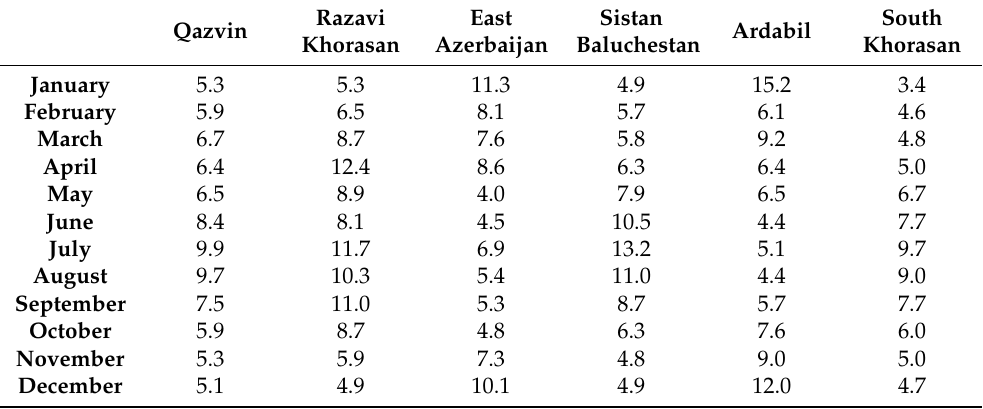
Figure 7. Electricity load and average temperature for Iran .